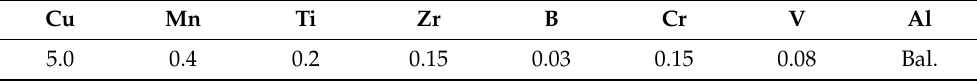
Table 1. Chemical composition of the Al-Cu-Mn-Ti alloy